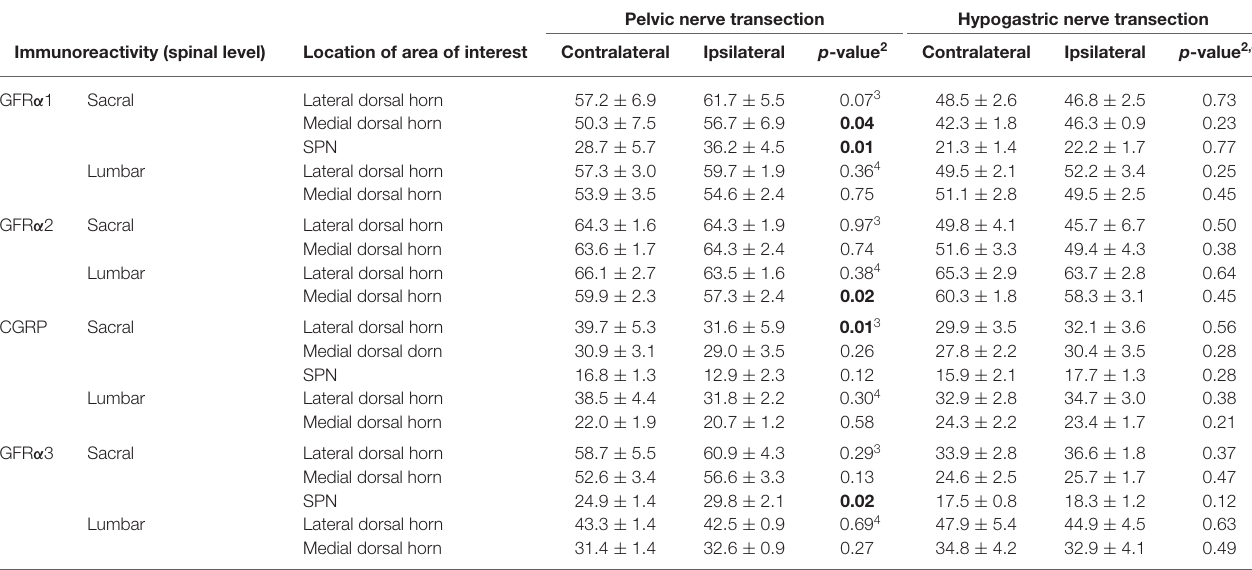
TABLE 1 | Optical density (mean ± SEM) of GDNF-family receptor alpha (GFR α )-immunoreactivity in sacral (L6/S1) and lumbar (L1/2) spinal cord segments following unilateral visceral nerve transection 1